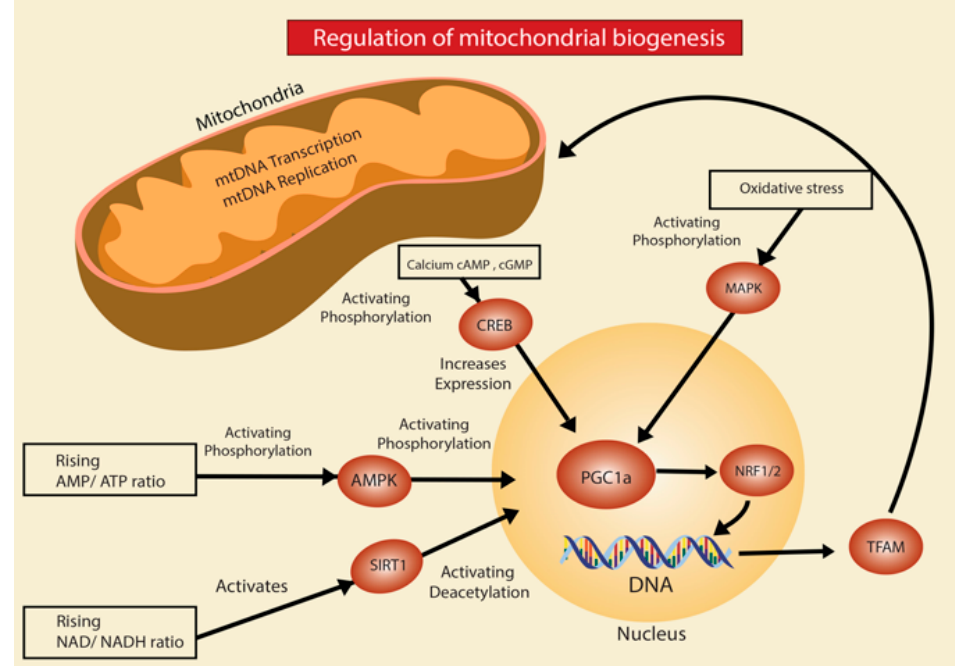
Figure 1. Regulation of mitochondria biogenesis. Activation of different signaling pathways, such as AMPK, SIRT1, CREB, MAPK has been associated with mitochondria biogenesis by increasing PGC-1a gene transcription. PGC-1a represents the major co-transcriptional factor that regulates mitochondria biogenesis by activating the nuclear respiratory factor 1 (NRF1) and nuclear respiratory factor 2 (NRF2) which leads to increase expression of mitochondrial transcription factor (Tfam), driving transcription and replication of mitochondria DNA (mtDNA).